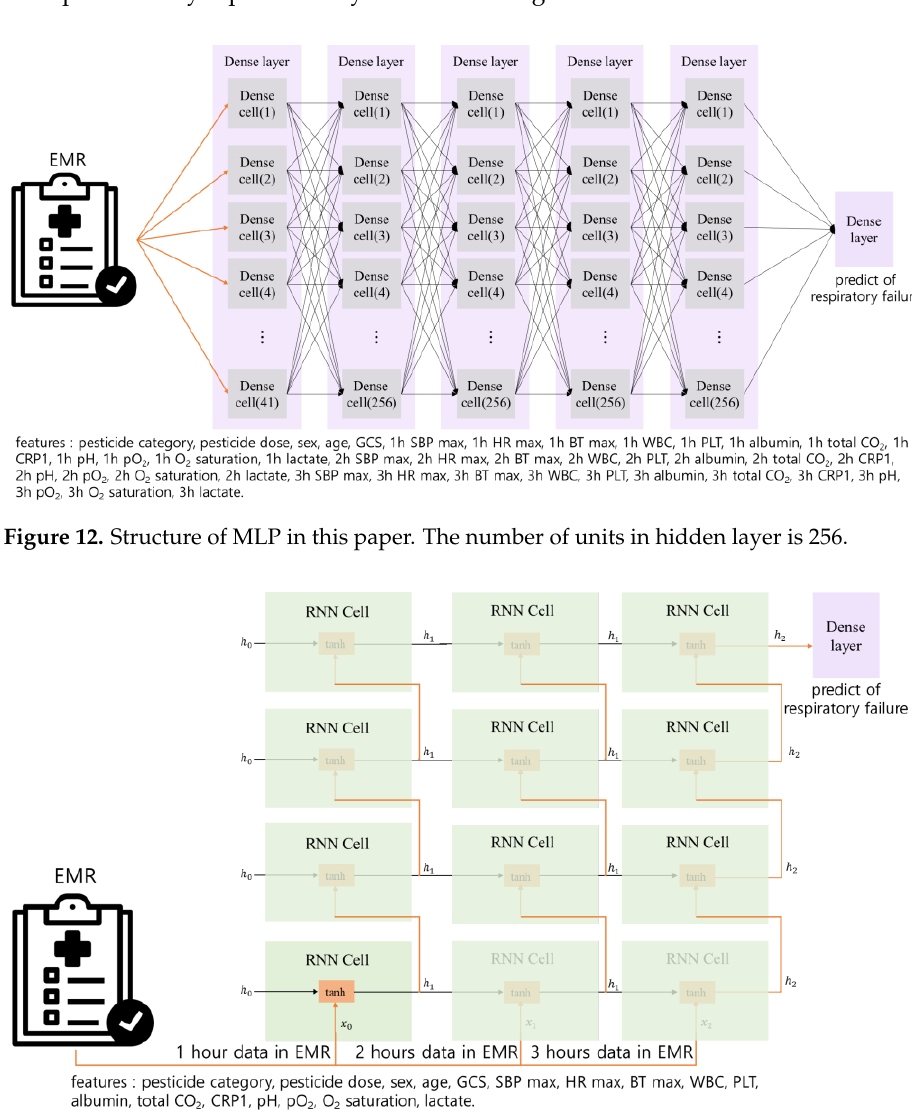
Figure 14. Structure of the LSTM model in this paper. The number of units in the LSTM layer is 128.